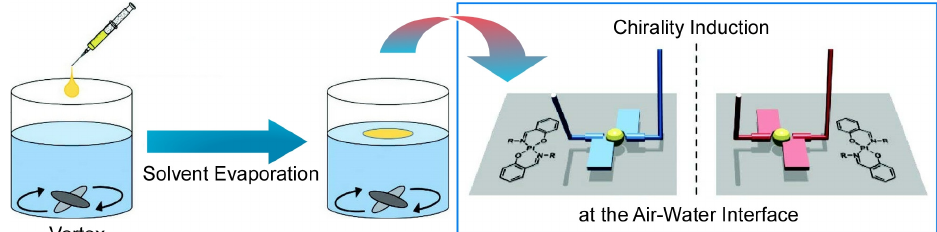
Figure 23. Control of the chirality of trans-bis(salicylaldiminato)platinum(II) complexes by the direction of the vortex flow at the air-water interface. Reprinted with permission from Reference [198]. Copyright 2022 Wiley-VCH.